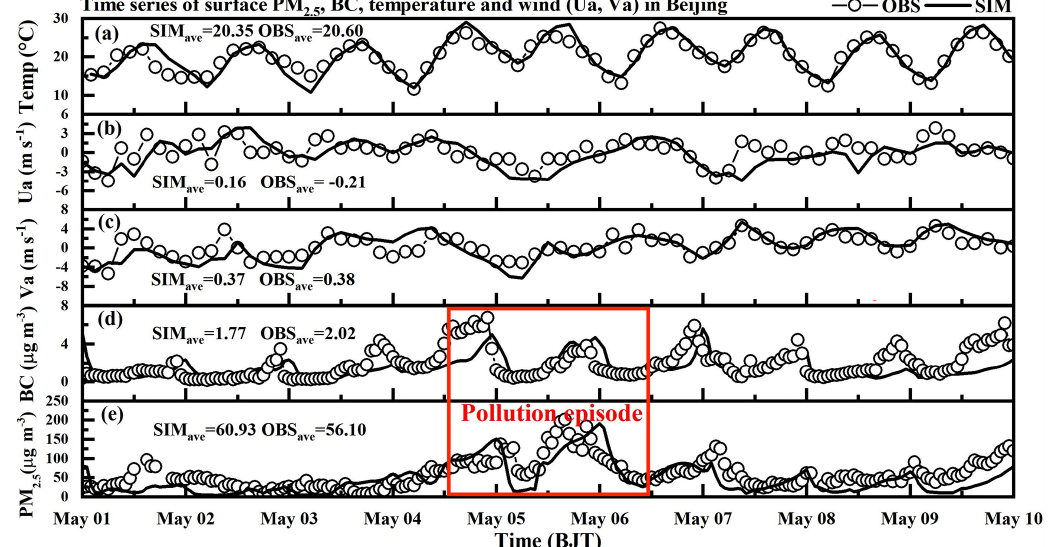
Figure 2. Time series of (a) temperature, (b) Ua , (c) V a , (d) BC, and (e) PM 2 . 5 at Beijing station. The red box indicates the pollution episode in this